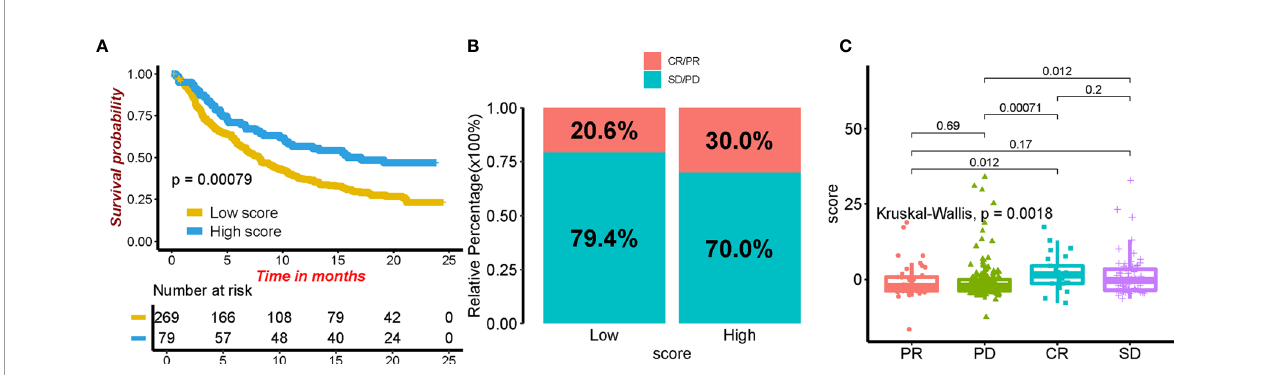
FIGURE 8 | The role of ICI score in predicting the response to immunotherapy. (A) Kaplan – Meier curves for patients in different ICI score groups. (B) The rate of response to immunotherapy in high and low ICI groups. (C) The distribution of ICI score in different